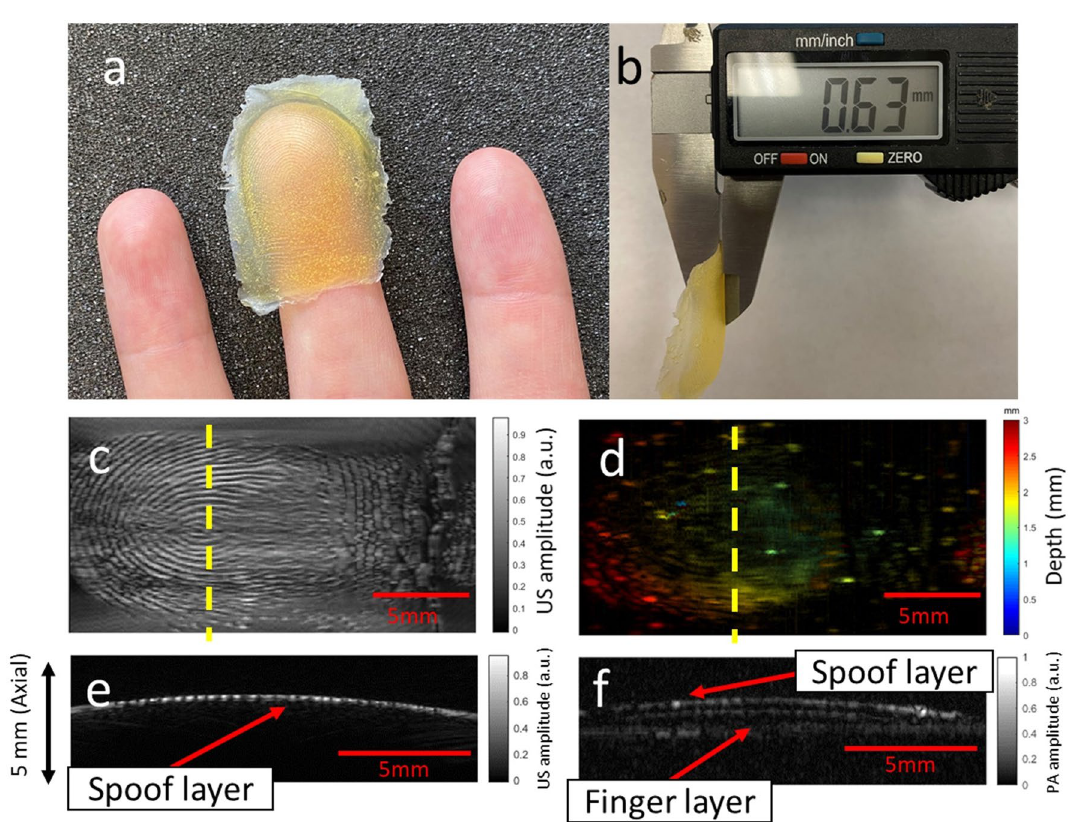
Figure 5. Imaging results of the thin-film spoof. ( a ) Photograph of spoof placed on human finger. ( b ) Thickness-measurement of spoof. ( c ) Ultrasound image. ( d ) Photoacoustic image. ( e ) Cross-sectional ultrasound image across the yellow dashed line in ( c ). ( f ) Cross-sectional PAT image across the yellow dashed line in ( d